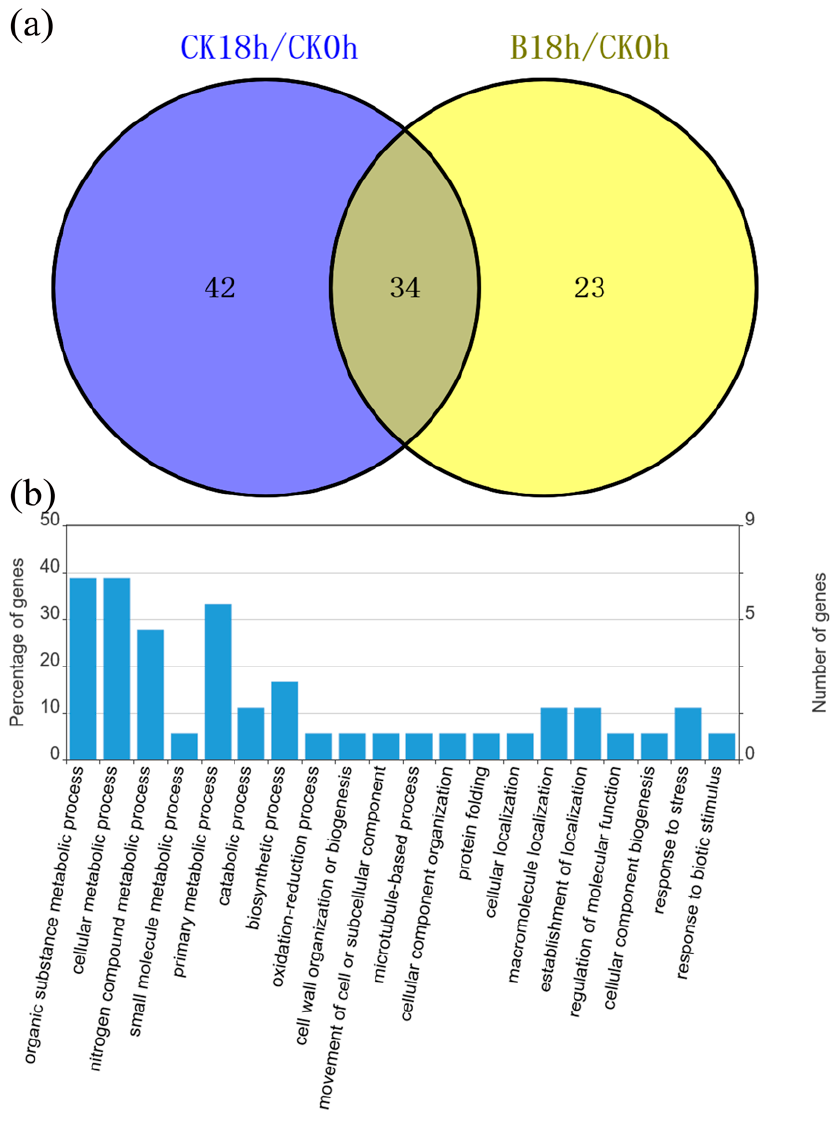
Figure 4. Differentially regulated proteins at priming stage. ( a ) The number of proteins regulated by priming at 18 h; ( b ) Gene Ontology (GO) analysis of the proteins differentially regulated at priming stage.